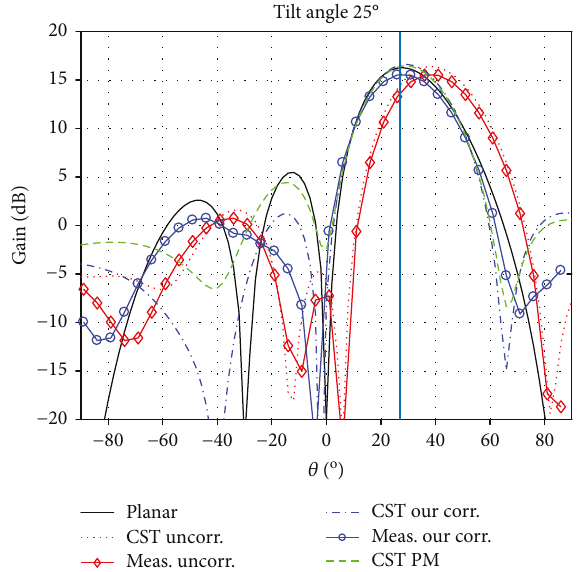
Figure 6: Simulated and measured 4 × 4 antenna gain: planar, uncorrected, corrected with our approach, and corrected with the projection method patterns on the yz -plane for θ